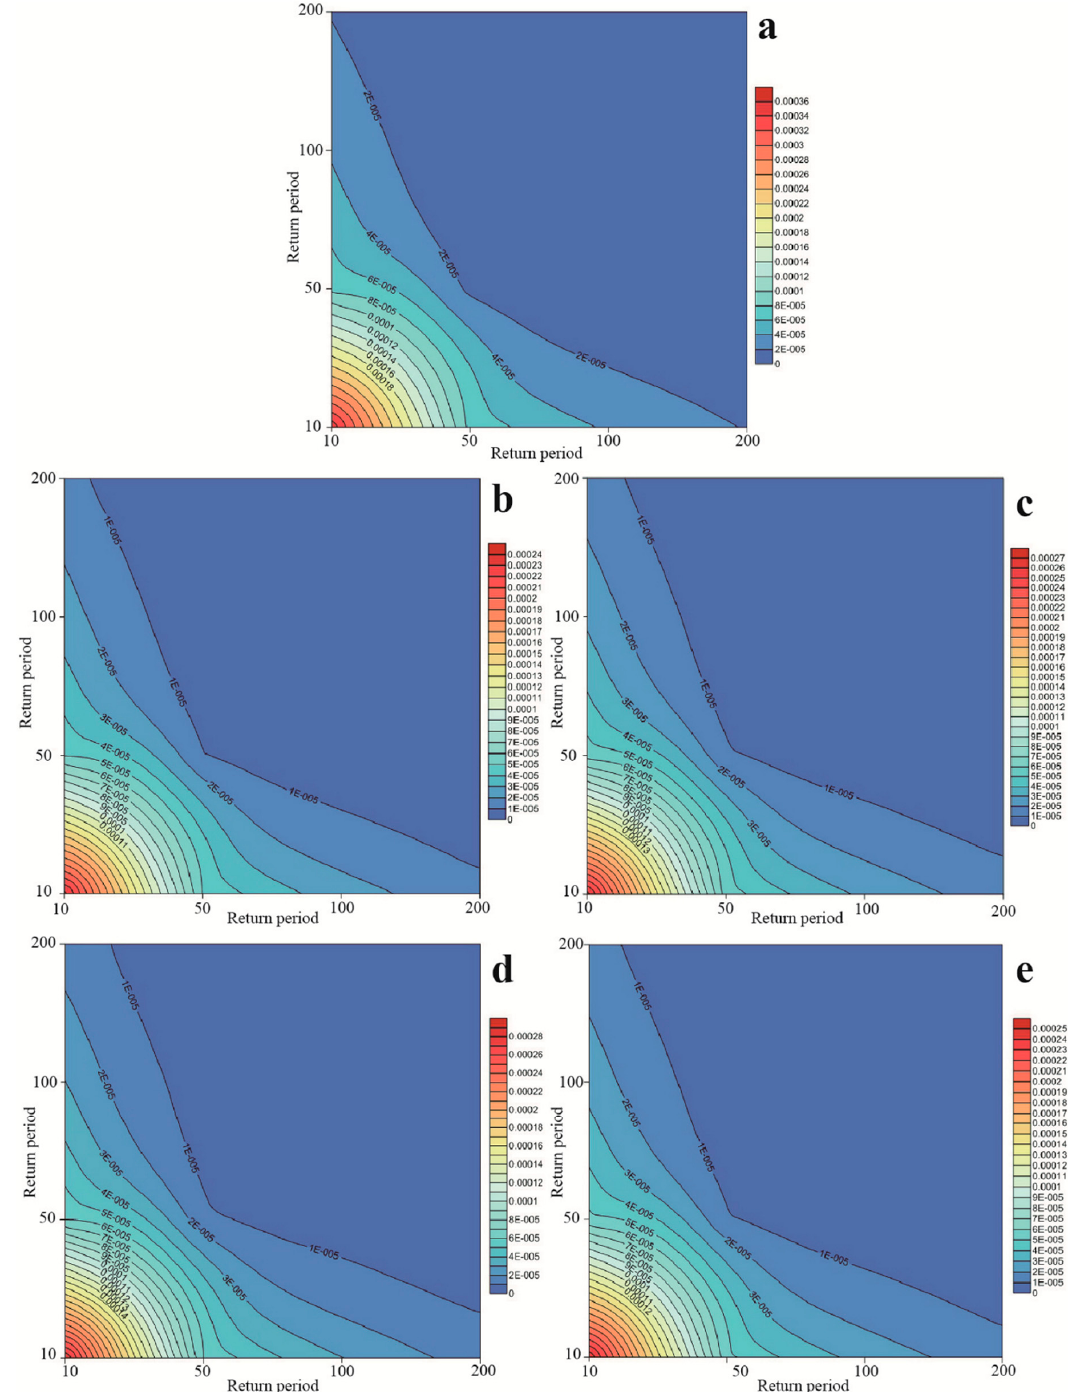
Figure 14. Encounter probability of drought in the non ‐ flood season. ( a ) The reference period. ( b ) 2020–2049 period of scenario A2. ( c ) 2070–2099 period of scenario A2. ( d ) 2020–2049 period of